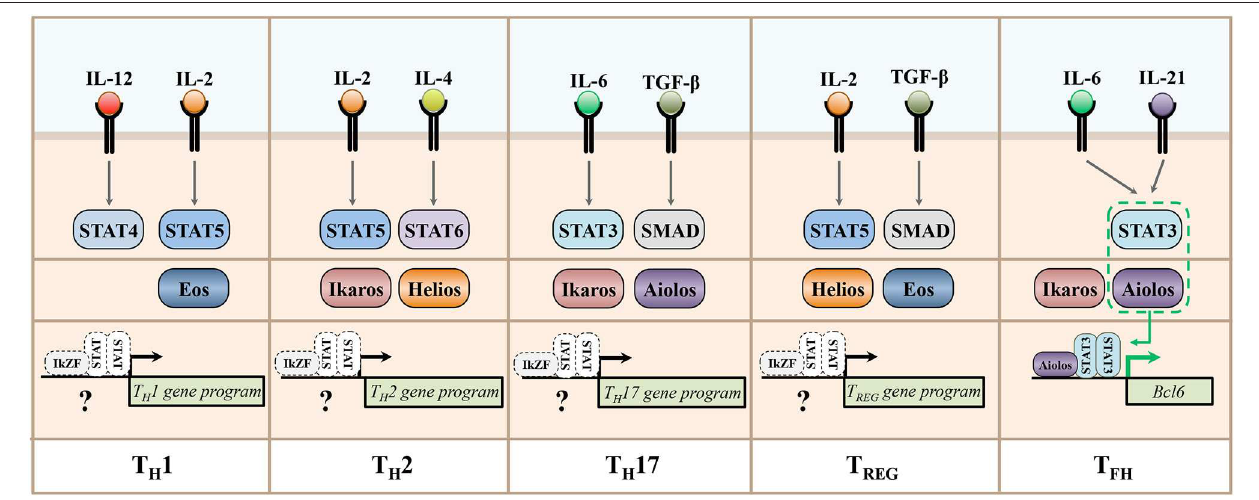
FIGURE 4 | STAT and IkZF regulatory networks underlying the expression of T helper cell gene programs. This schematic depicts representative cytokines implicated in the development of murine T helper cell populations, their downstream STAT signaling pathways, and the Ikaros zinc finger transcription factors recently associated with the differentiation and functions of each subset. A recent study demonstrated that the IkZF factor Aiolos cooperates with STAT3 to induce the expression of Bcl6 , the lineage-defining transcription factor for the T FH cell type. The differential expression and/or activity of IkZF and STAT factors across T helper cell subsets is suggestive of the intriguing possibility that additional, cell type-specific STAT/IkZF regulatory modules may regulate T helper cell differentiation decisions across